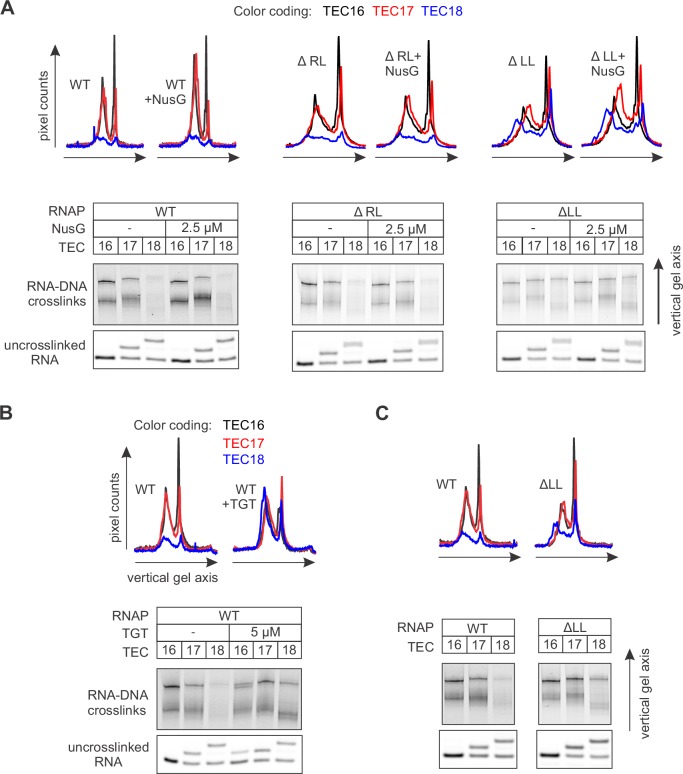
The effects of NusG (A), TGT (B) and ΔLL (C) on RNA:DNA photocrosslinking with 6-TG.This figure presents the independent repeats of the experiments in Figure 5. The gel panels were spliced from the same gel and the pixel counts were linearly scaled to span the full 8 bit grayscale range within each panel. The pixel intensity profiles for each gel lane are shown above the gels.